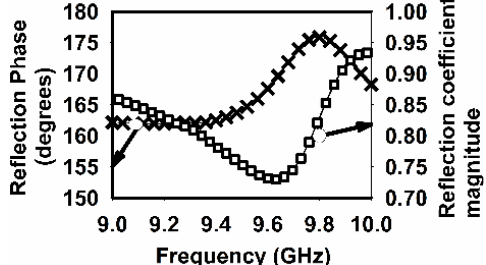
Figure.5. Simulated response from bottom surface of checkerboard unit